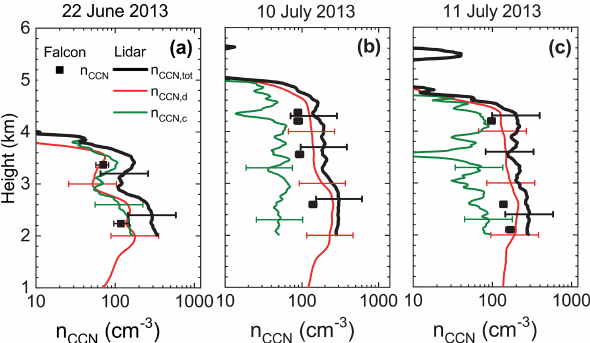
Figure 3. Lidar-derived CCN number concentrations at 0.2% su- persaturation (black line) with contributions from dust (red line; critical dry diameter of 200nm) and continental pollution aerosol (olive line; critical dry diameter of 100nm) compared to coincident airborne in situ measurements (black squares) during SALTRACE- 1. The error bars of the lidar profiles indicate an uncertainty of a factor of 2. The error bars of the in situ measurements indicate the 16th and 84th